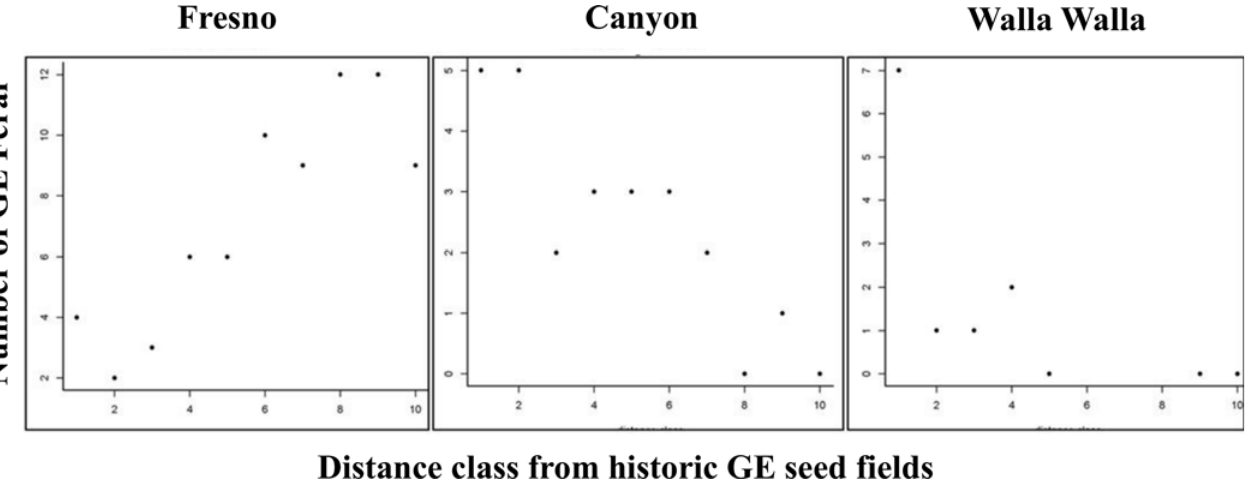
Fig 4. Number of GE feral population occurrences relative to the distance from historic GE seed fields. Relationship was significant but inconsistent across counties. In Fresno County, transgenic feral populations occurred more frequently at further distances from the single historic seed field, while in Canyon and Walla Walla counties, transgenic populations occurred closer to historic GE seed